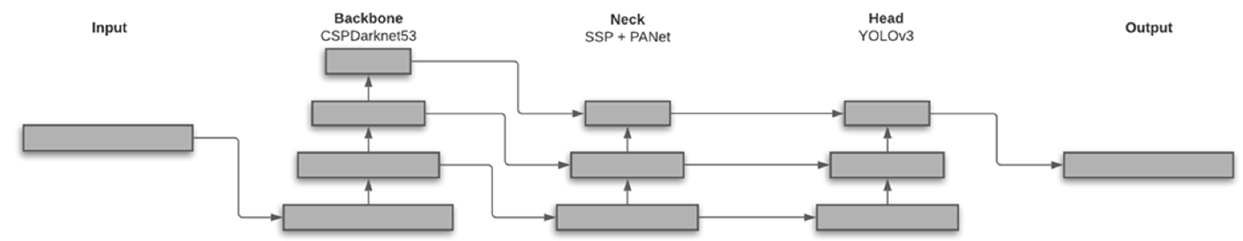
Figure 10. General structure of YOLOv4.